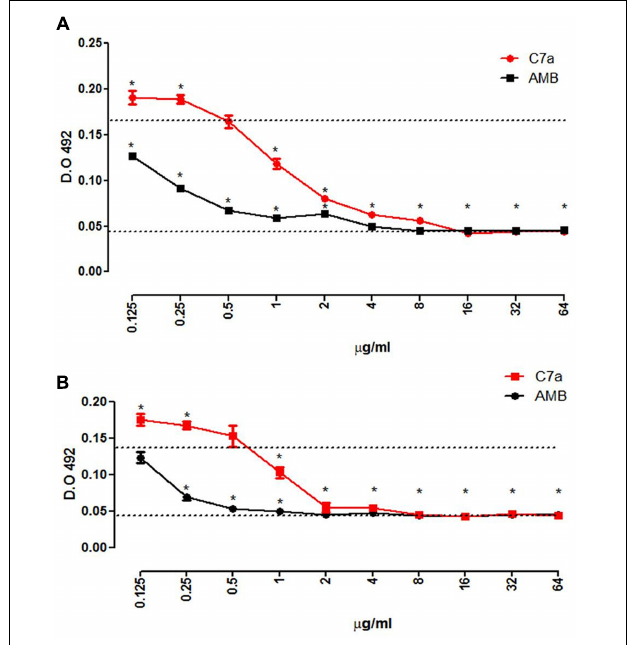
FIGURE 3 | C7a affects the maturation process and the mature biofilm. Effect of C7a or AMB in the mature biofilm (A) and in the maturation of the biofilm (B) of C. albicans ATCC 10231 was determined by XTT reduction assay. Upper dotted line represents the untreated positive control, and the lower dotted line represents the negative control. Mean and standard deviation of each point is shown. ∗ P < 0.05, determined by analysis of t -test two-tailed compared to the positive control.